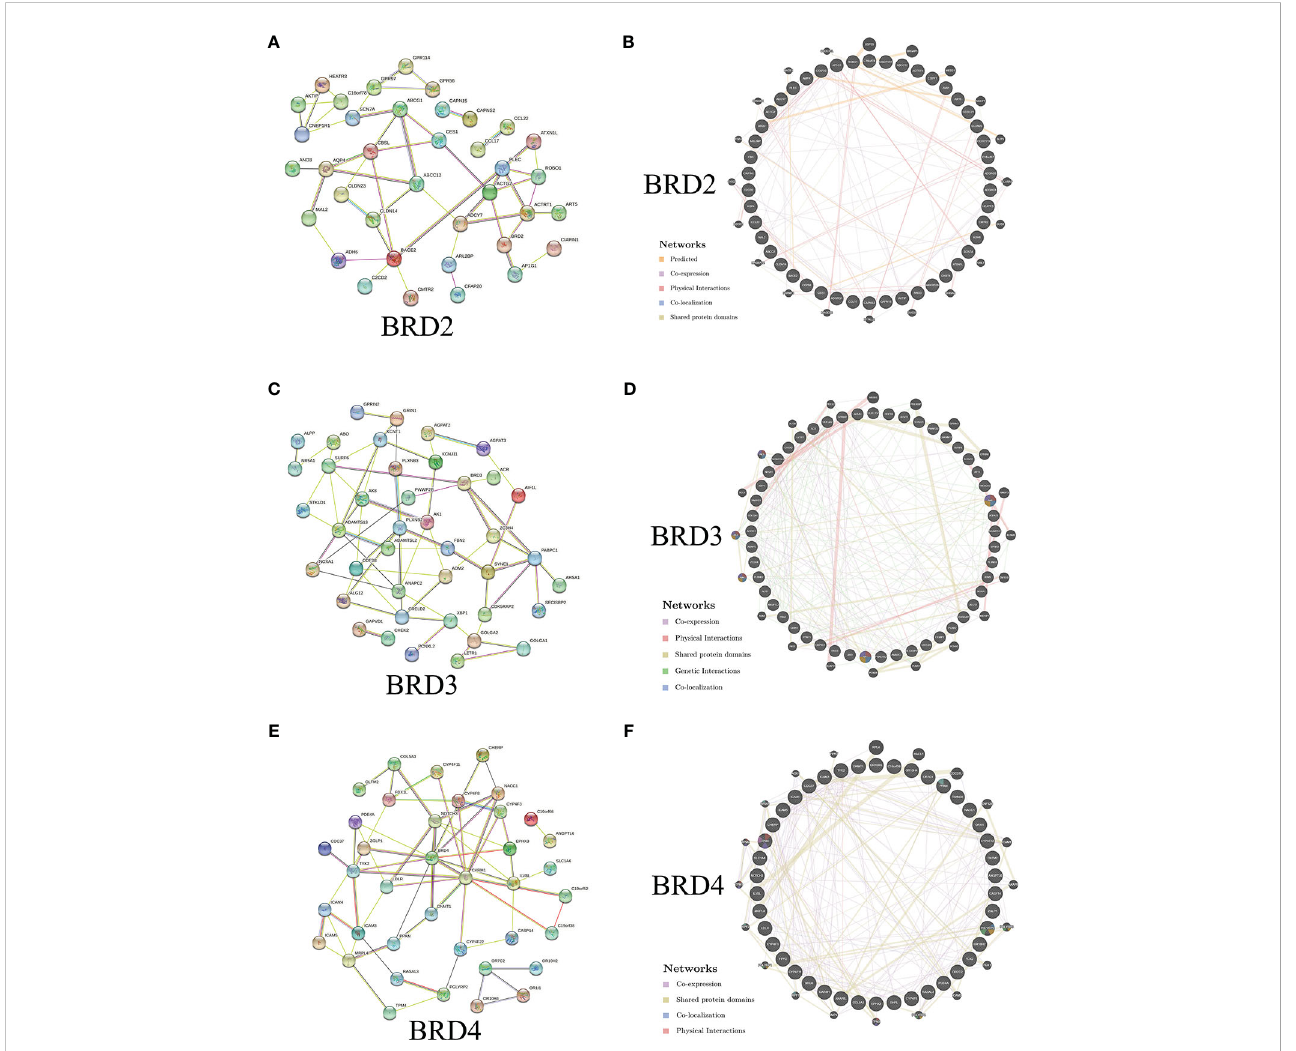
FIGURE 2 Interaction analyses of BET family and their neighboring genes in ACC (STRING and GeneMANIA). (A) PPI network of BRD2 and its neighboring genes in patients with ACC (STRING); (B) Network analyses of BRD2 and its neighboring genes in patients with ACC (GeneMANIA); (C) PPI network of BRD3 and its neighboring genes in patients with ACC (STRING); (D) Network analyses of BRD3 and its neighboring genes in patients with ACC (GeneMANIA); (E) PPI network of BRD4 and its neighboring genes in patients with ACC (STRING); (F) Network analyses of BRD4 and its neighboring genes in patients with ACC